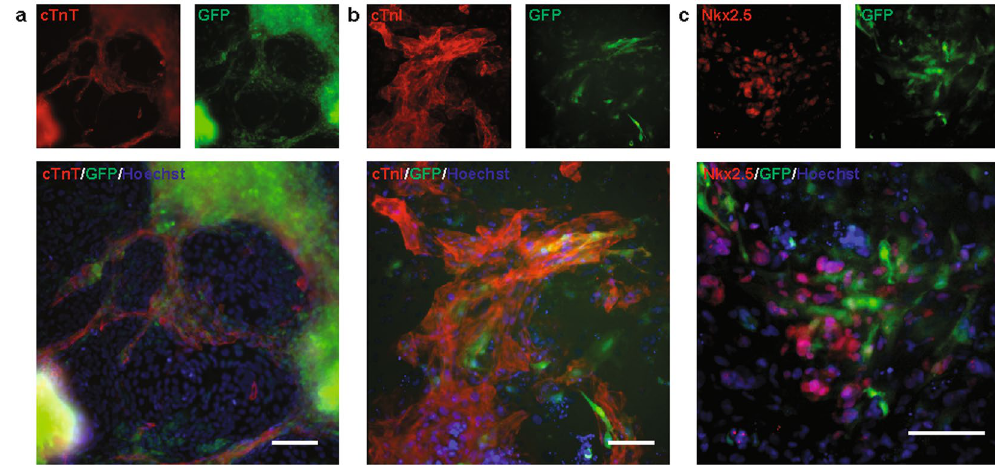
Figure 4. Characterization of GFP expression in differentiated cells. Immuno-fluorescence imaging showing the co-localization of GFP expression and cardiomyocyte markers cTnT ( a ), cTnI ( b ), and Nkx2.5 ( c ) in hPSC derived cardiomyocytes. Scale bars are 100 µ